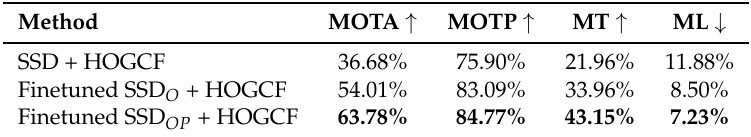
Table 1. Analysis of training data augment strategy on validation